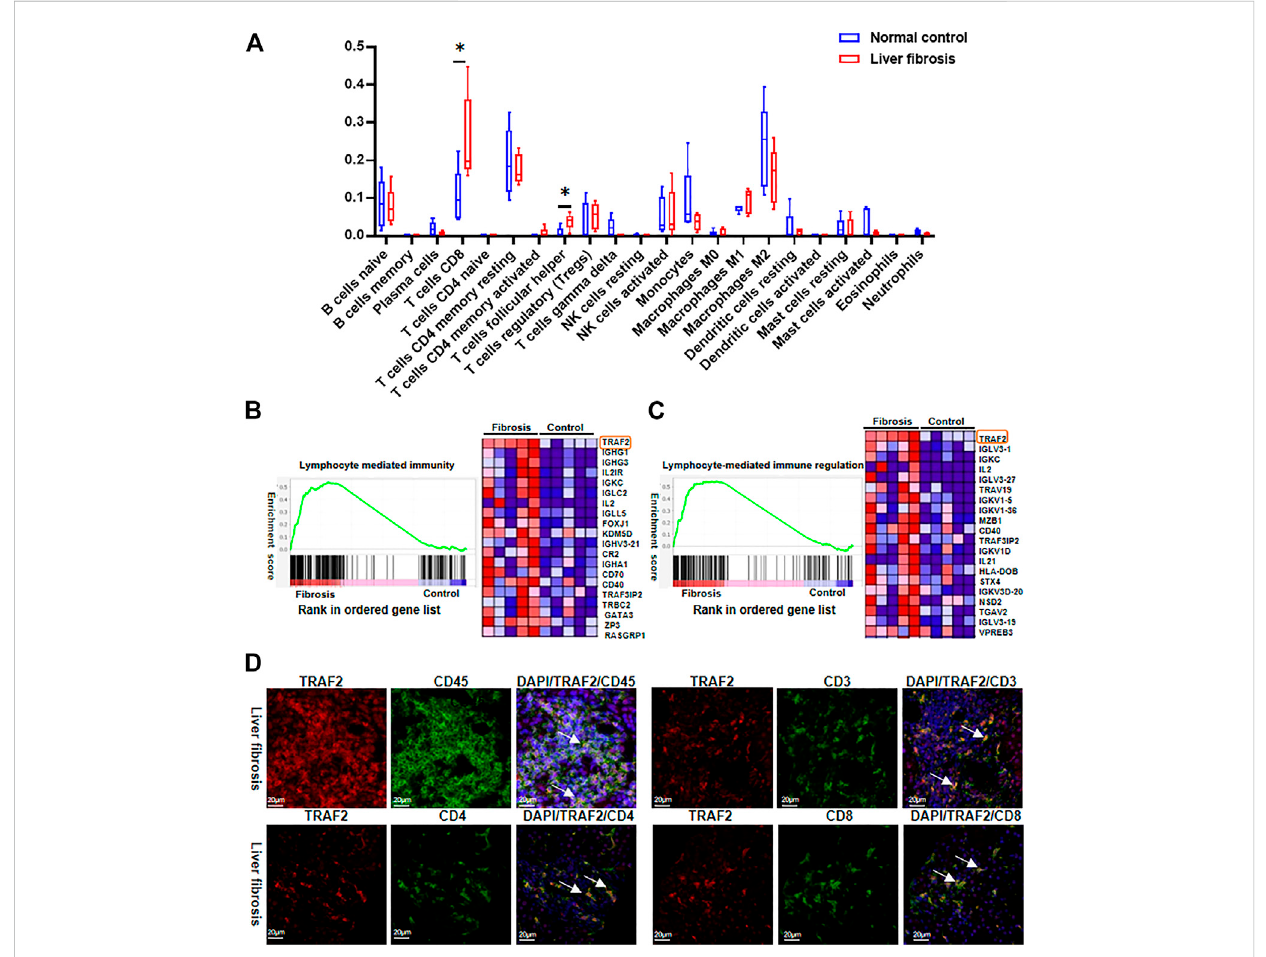
FIGURE 6 CharacterizationofTRAF2expressioninimmunecells. (A) RNA-seqdatawasanalyzedforimmunocellin fi ltrationusingtheCIBERSORTxwebsite. (B) Lymphocyte-mediated immunity GO enrichment in GSEA. (C) Regulation of lymphocyte-mediated immune regulation GO enrichment in GSEA. (D) AccordingtotheMaterialsandMethods,animmuno fl uorescence(IF)studywasperformedtodeterminethelocationofTRAF2inlivertissuesonacellular level.Therepresentativedoubleimmuno fl uorescencepicturesshowthatHBV- fi broticlivertissuesexpressCD45(green),CD3(green),CD4(green), CD8 (green), and TRAF2 (red). Scale bar: 20 μ m * p < 0.05. TRAF2, TNF receptor associated factor 2; CD45, cluster of differentiation 45; CD3, cluster of differentiation 3; CD4, cluster of differentiation 4; CD8, cluster of differentiation